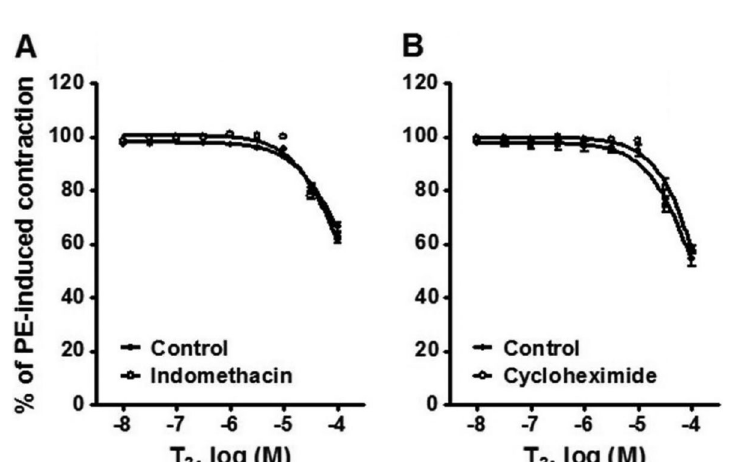
Figure 5. Vasorelaxation produced by 10 -8 – 10 -4 M T 3 in phenylephrine (PE)-precontracted rat aortic rings. Assays were carried out to test the effect of: A , 10 -5 M indomethacin, and B , 10 -5 M cyclohex- imide. Data are reported as means ± SE (n=8).